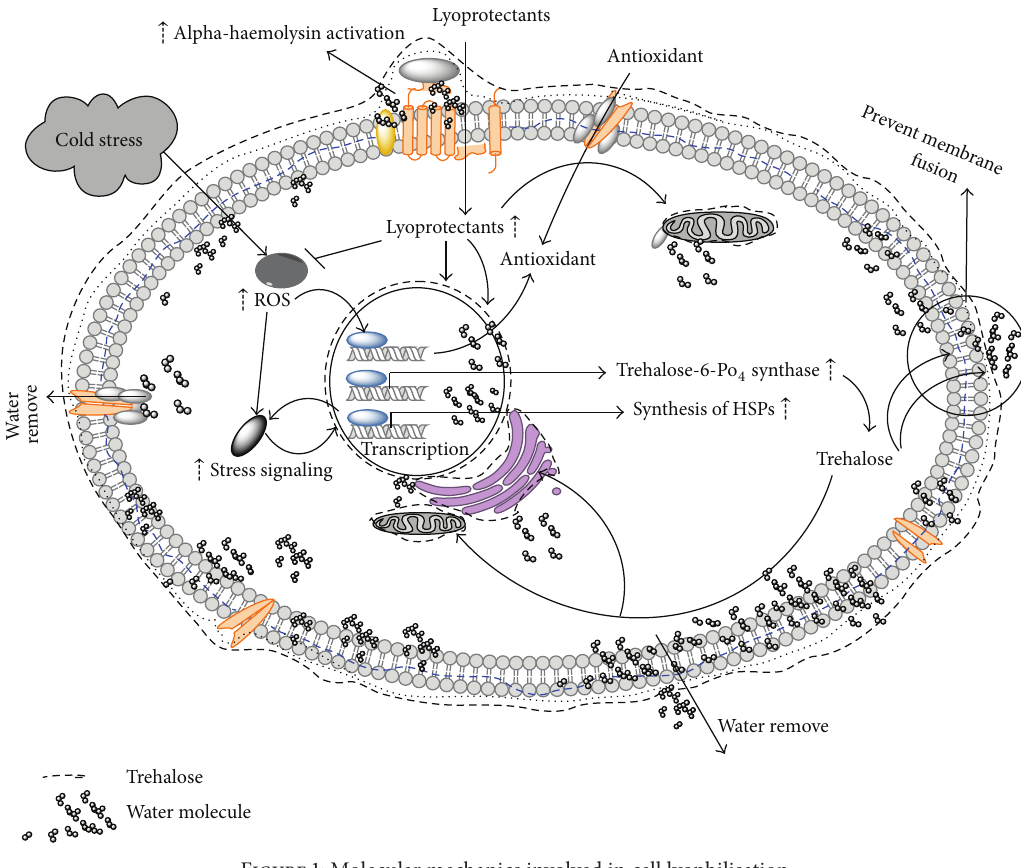
Figure 1: Molecular mechanics involved in cell